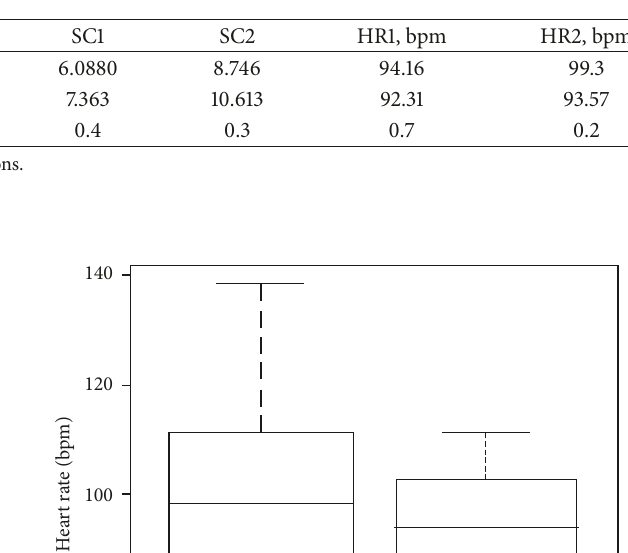
Table 1: Differences of the FLACC scale (at the time of anesthetic infiltration) and heart rate and skin conductance between groups (before and during anesthetic infiltration).